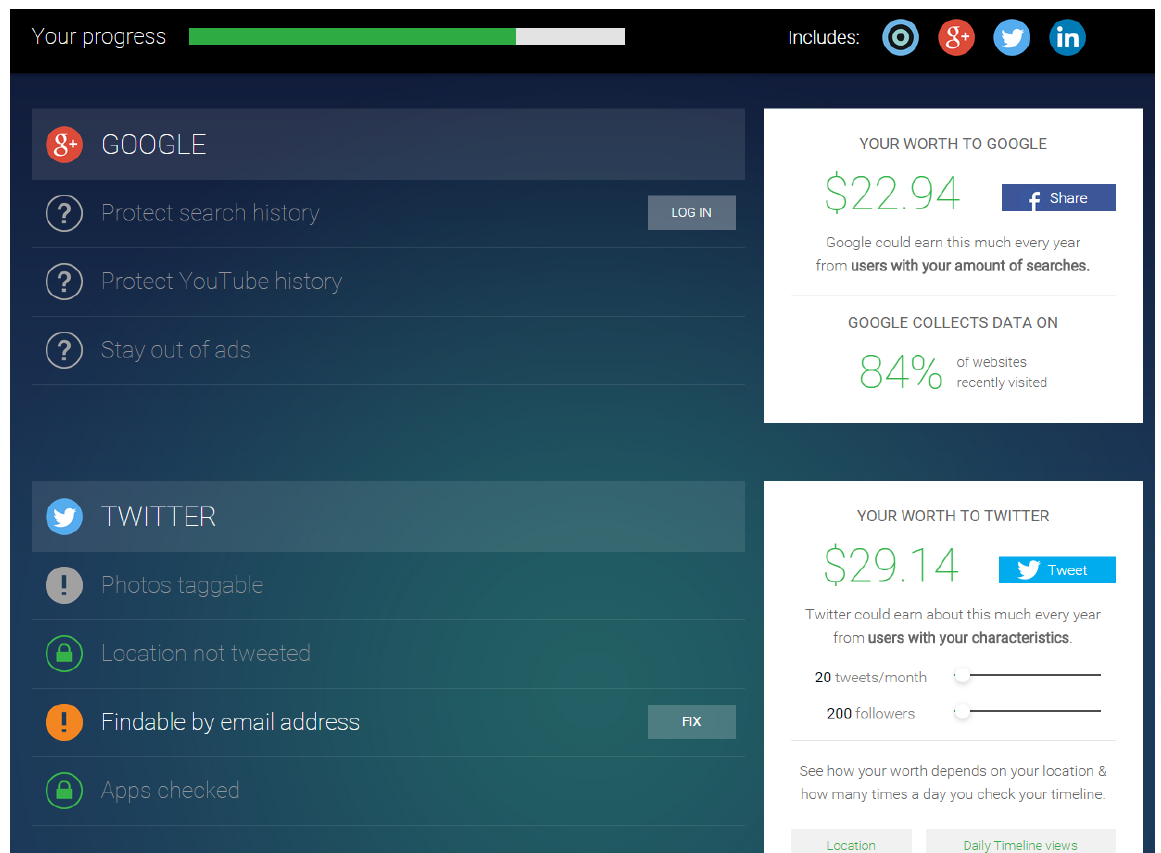
Figure 2. AVG PrivacyFix user